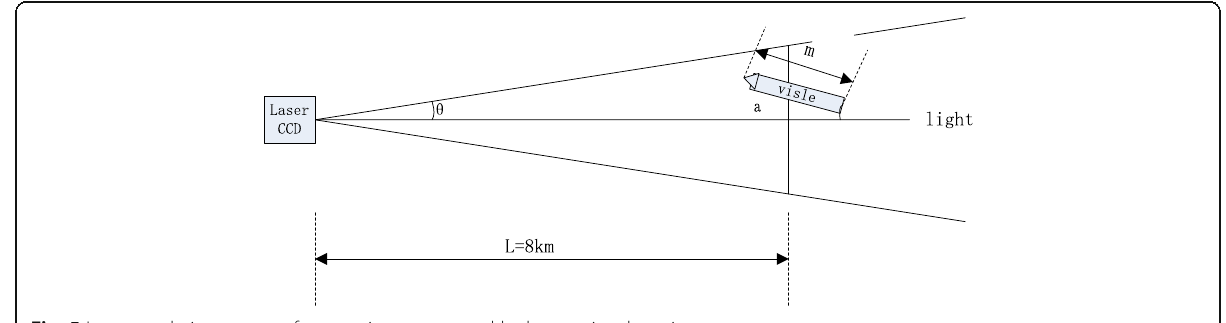
Fig. 5 Image analysis accuracy of cat eye image captured by laser active detection